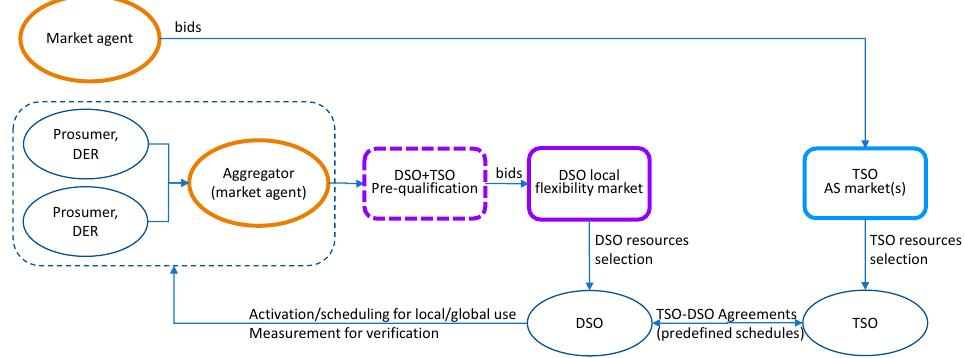
Figure 3. Local (DSO) and global (TSO) flexibility markets with resources sharing (M2).